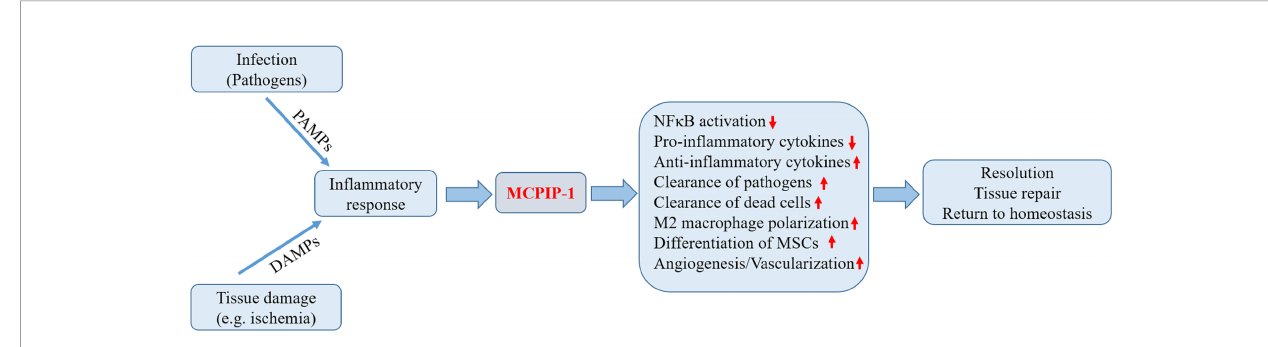
FIGURE 2 | Biological roles of MCPIP-1 associated with resolution of in fl ammation. During the early phase of in fl ammation, in fl ammatory response initiated by infection or tissue injury activates the endogenous defense mechanisms aimed to bring about proper resolution. The expression of MCPIP-1 induced by the in fl ammatory response modulates a wide range of cellular and molecular events associated with the resolution of in fl ammation. The expression of MCPIP-1 results in the suppression of NF k B activation and reduced pro-in fl ammatory cytokines. MCPIP-1 is able to induce apoptosis of infected or damaged cells, leading to their clearance by macrophages. In addition, MCPIP-1 promotes M2 macrophage polarization and enhances angiogenic differentiation of mesenchymal stem cells (MSCs). These events will create a favorable environment contributing to the resolution and tissue